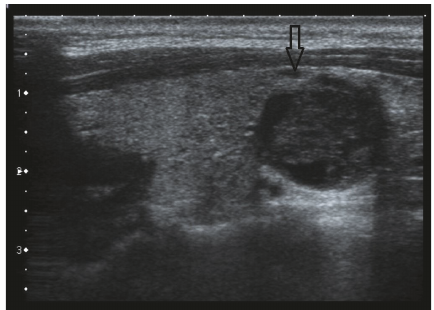
Figure 2: Ultrasound neck showing a well-defined hypoechoic parathyroid adenoma